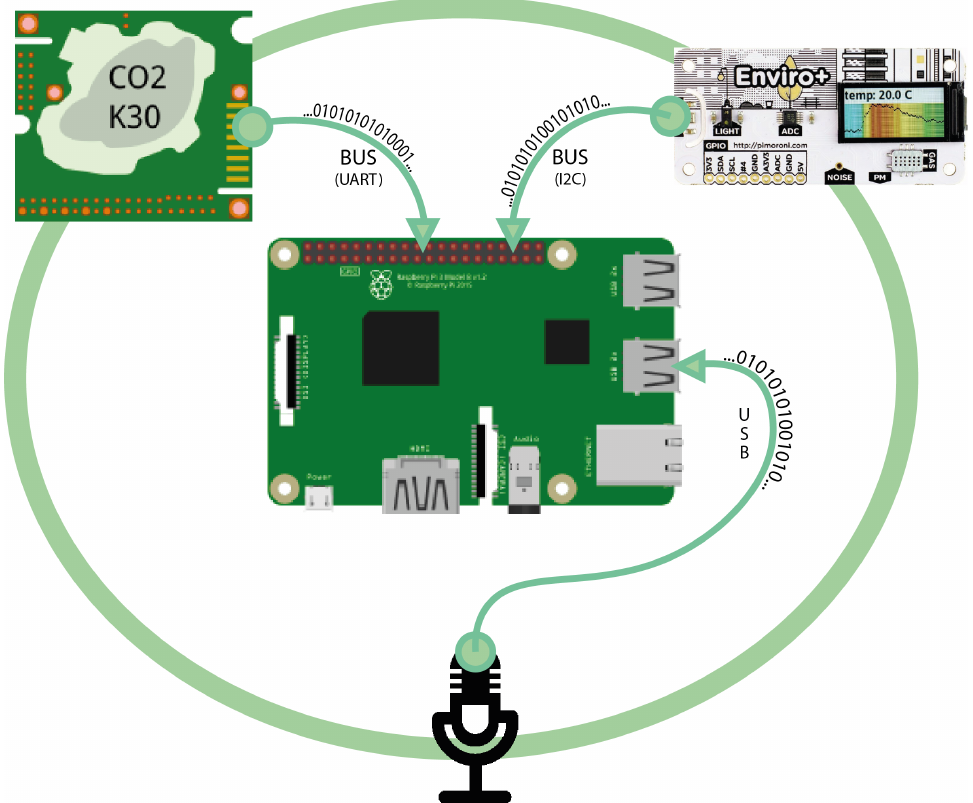
Figure 1. Wireless IEQ logger: hardware architecture.